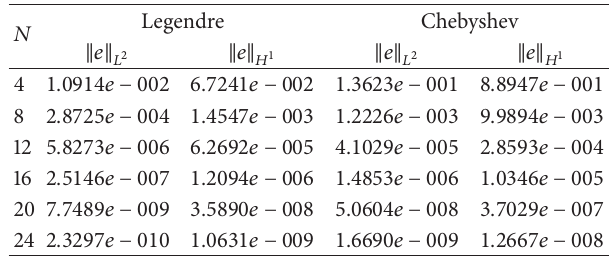
Table 4: Error discretization for Example 2. Table 5: Error discretization for 𝐶 = 0.1 and 𝑏 = −3 for Example